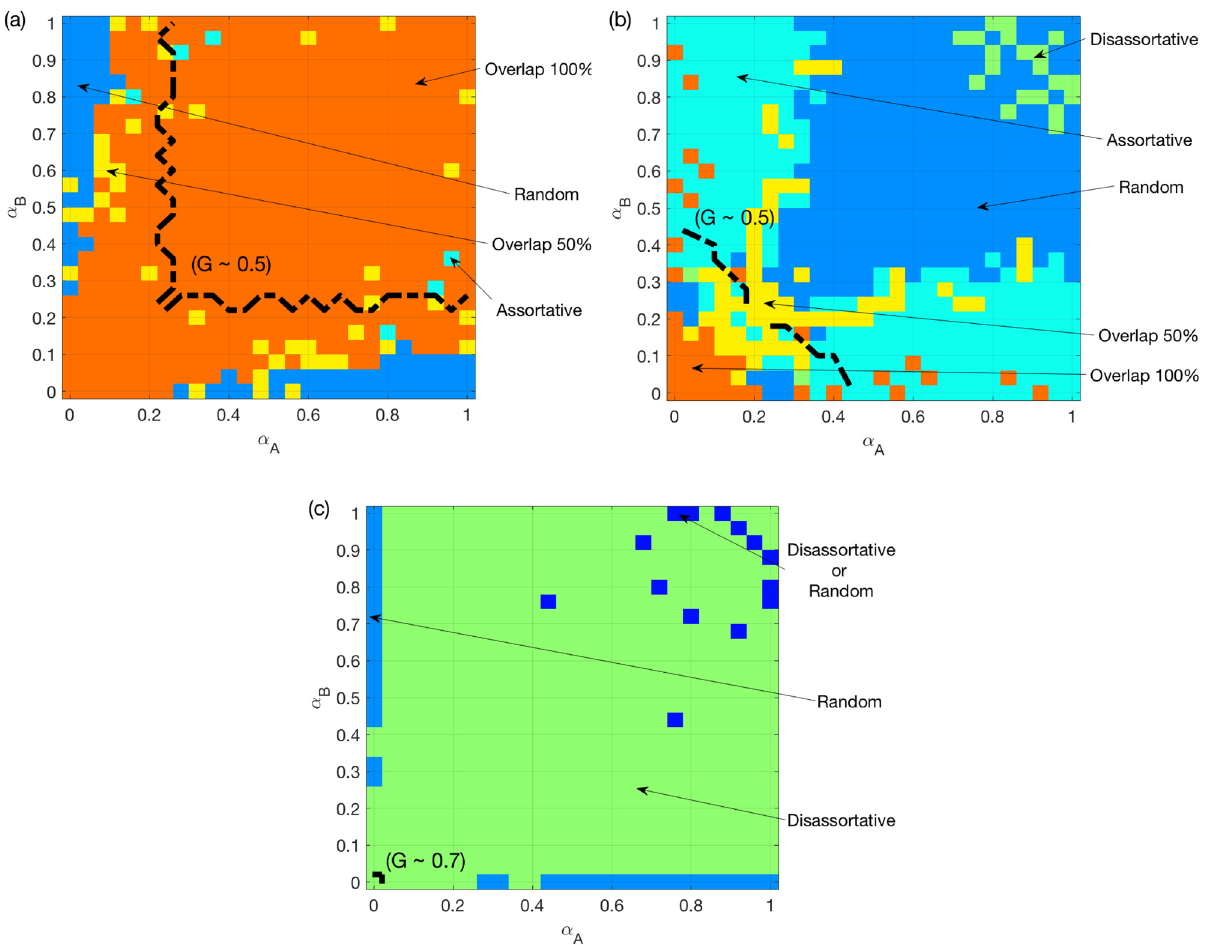
Fig 7. Best choice of coupling schemes for two SF networks. (a) OR rule. (b) SUM rule. (c) AND rule. N = 500, k A = k B = 6, averaged over M = 50 realizations. The color for certain α A and α B values indicatesthe best couplingscheme havingthe largest mean G value. A dashed line is addedto each sub-figure to indicate the locationwhere the best mean G reaches0.5, and 0.7 for (c).